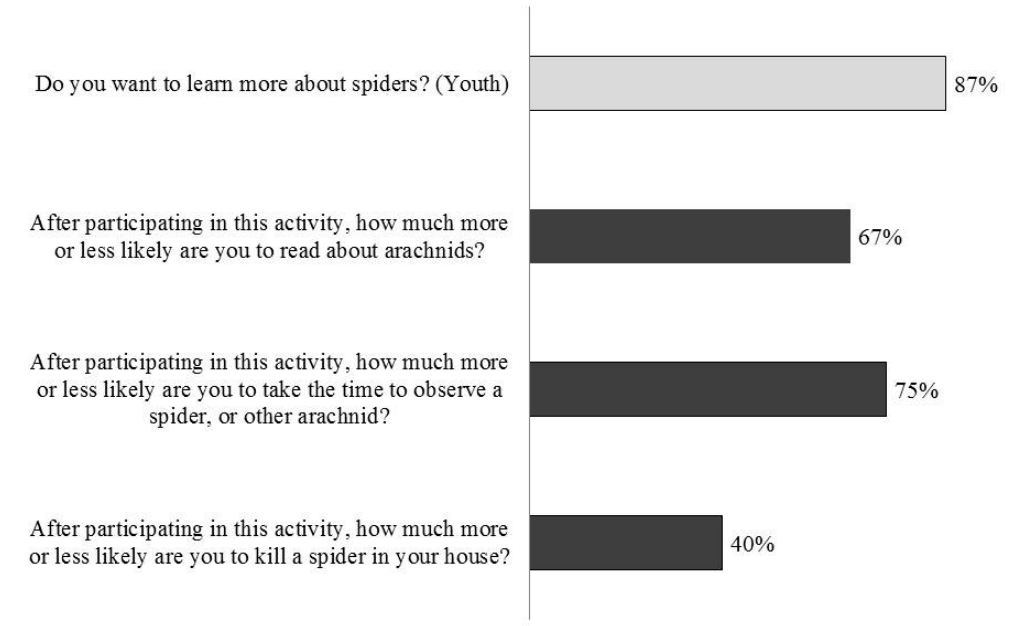
Figure 7. The majority of adult and youth participants reported increased interest in spiders or to relevant questions. The youth question (top) shows the proportion of youth responding “yes”. Adult questions show the combined adult responses from “much more likely” and “more likely”, except in the case of the “kill a spider in your house” question, which shows results of “much less likely” and “less likely”. (Data not included for UNSM 2013)